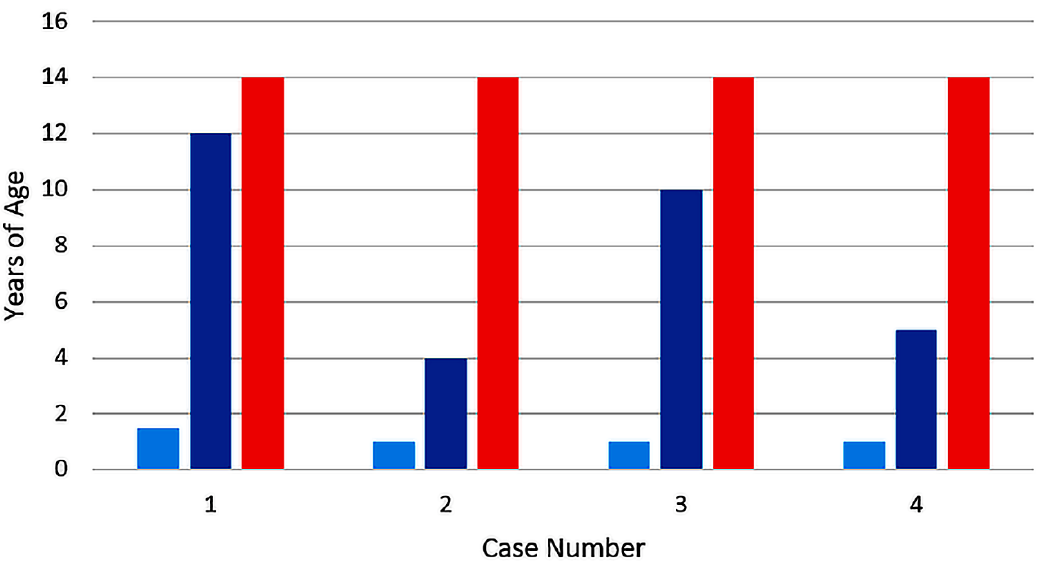
Figure 2. Duration between varicella vaccination and varicella vaccine meningitis in four children. All children had received two varicella vaccinations. All four children developed herpes zoster and meningitis 13 years after their first vaccination. Data from references [1,10,11]. Age of first varicella vaccination: light blue bar; age of second vaccination: dark blue bar; age of meningitis: red bar.